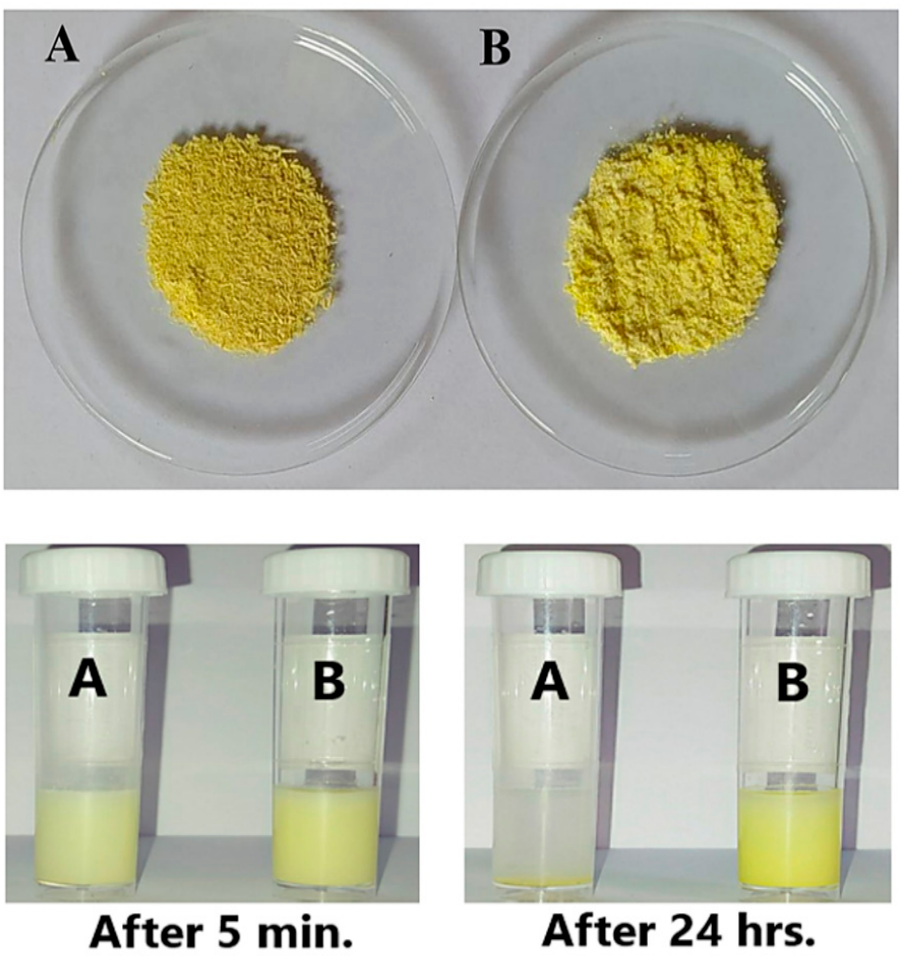
Figure 1. (Upper image) ( A ) Pure galangin and ( B ) GAL/ β -CD powders and (lower image) the solubility of ( A ) pure galangin and ( B ) GAL/ β -CD at 5 min and after 24 h of